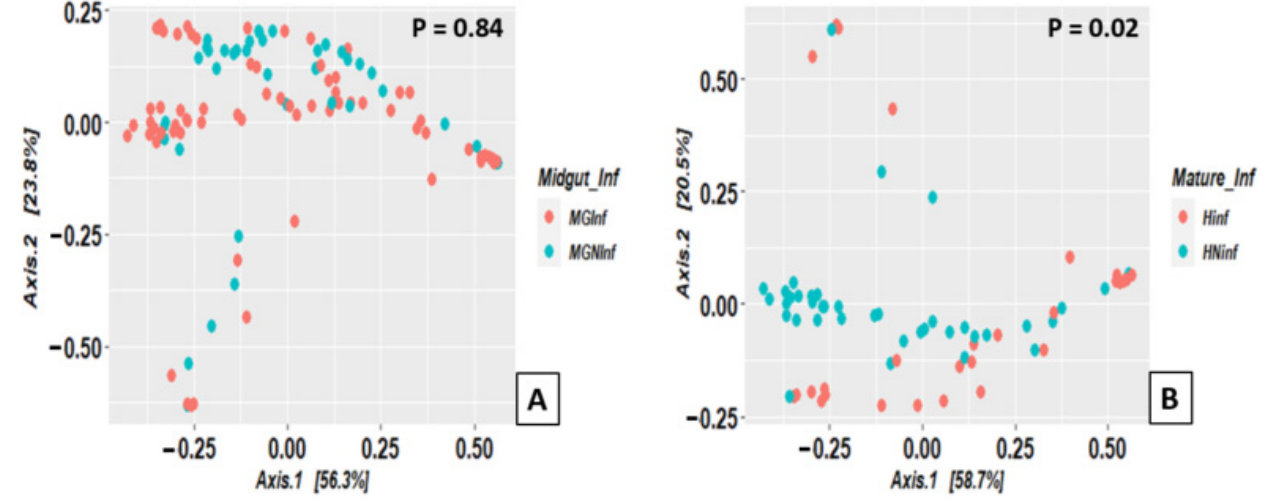
Figure 9. Distribution of tsetse fly samples according to their microbiome composition, based on principal coordinates analysis using the Bray–Curtis index, within trypanosome infection status: ( A ) midgut infection, ( B ) mature infection (MGInf: midgut infected; MGNInf: midgut non-infected; Hinf: head infected or mature infection; HNinf: head non-infected).